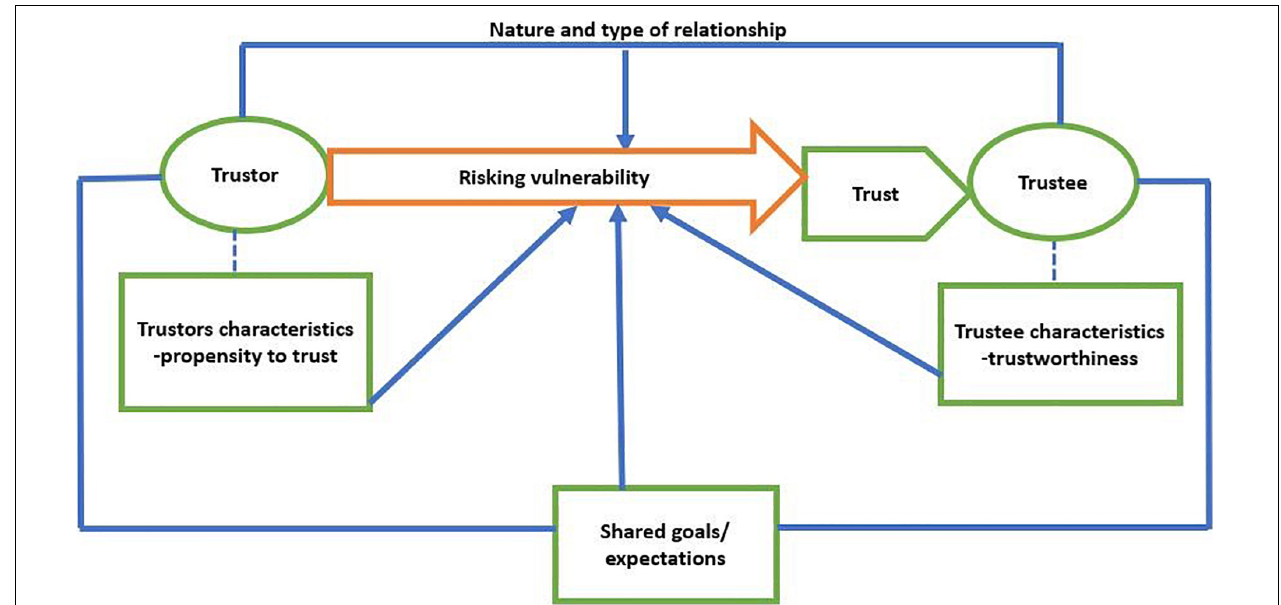
FIGURE 3 | Proposed trust